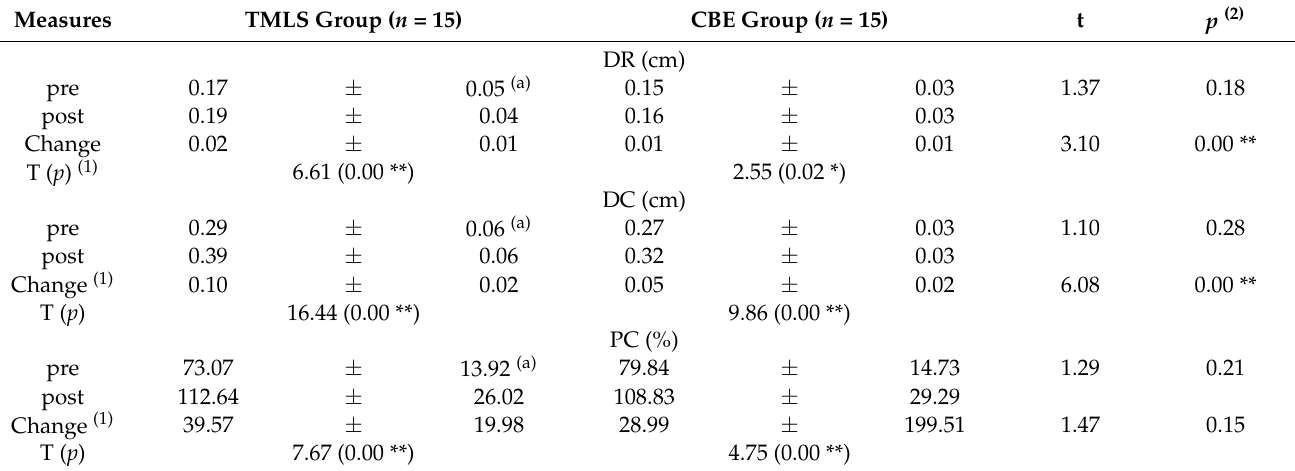
Table 2. A comparison of diaphragmatic thickness pre- and post-intervention ( n =